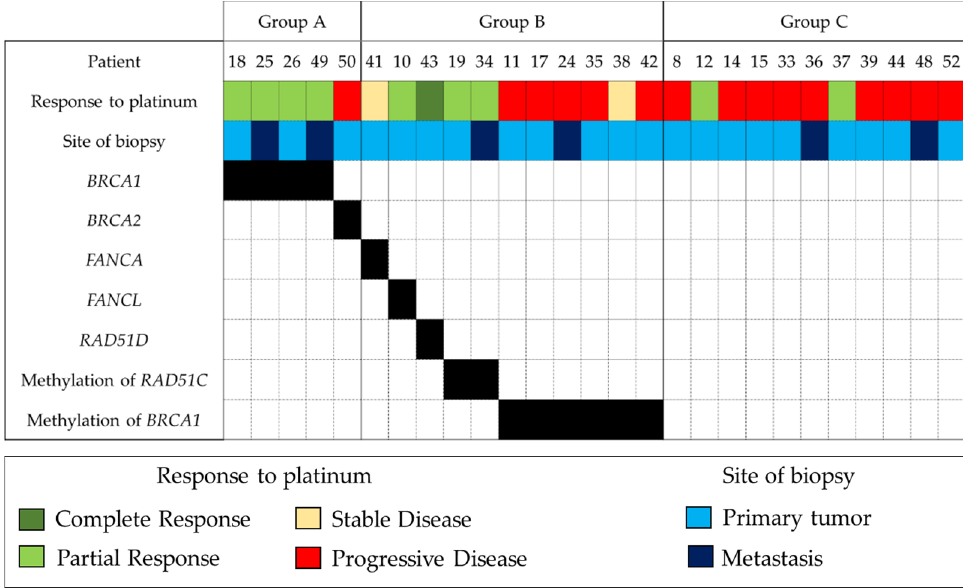
Figure 3. Site of biopsy, molecular status and radiological response for each patient challenged with platinum-based chemotherapy . A black square indicates the presence of a given molecular alteration